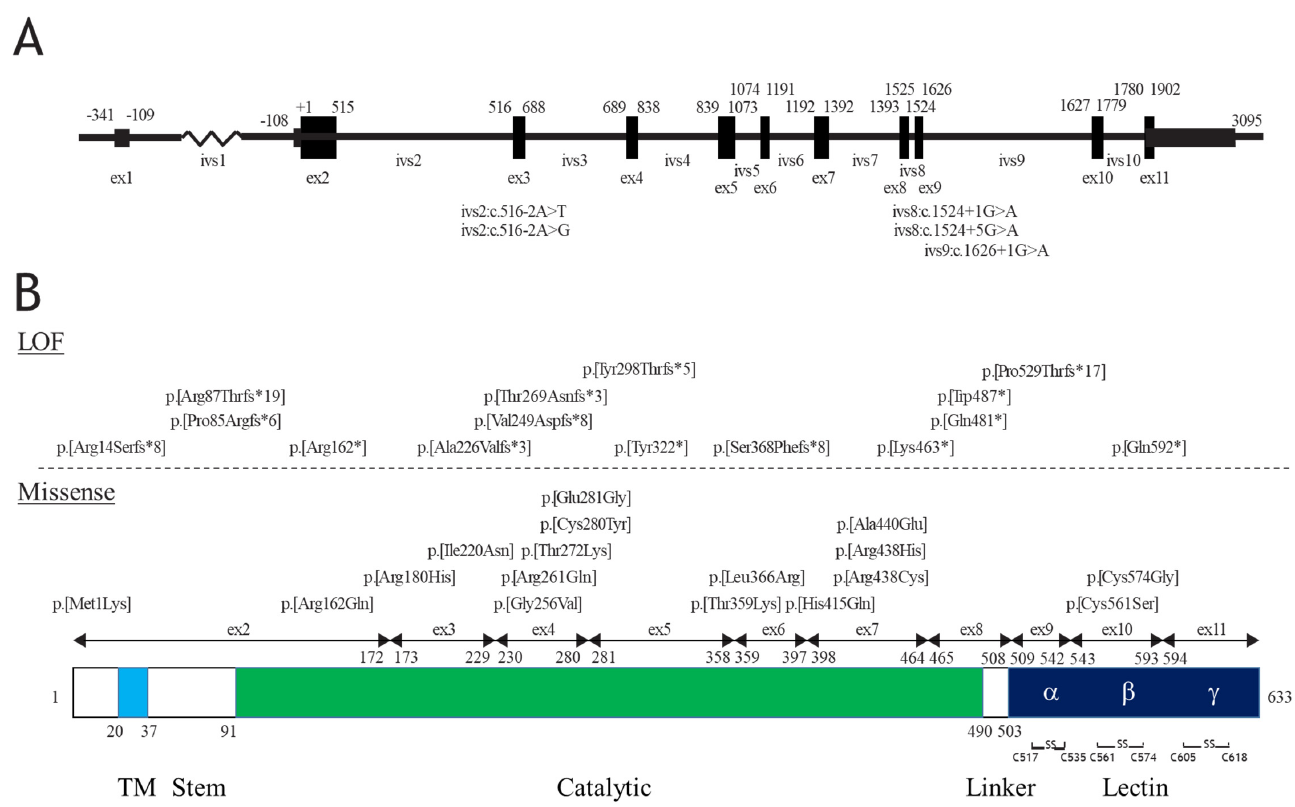
Figure 1. GALNT3 and GalNAc-T3 mutations reported in HFTC patients. ( A ) Structure for the GALNT3 transcript (NM_004482.4) with positions of exons in the transcript. Note that exon1 is non-coding. Splice site variants are shown with the position in the corresponding introns. ( B ) The protein domain structure of GalNAc-T3 with the exon positions and LOF and missense mutations is shown. ex; exon.